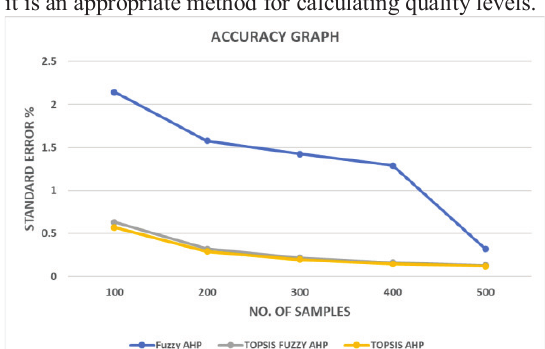
Fig. 2. Comparison of Standard Error with respect to No. of Samples